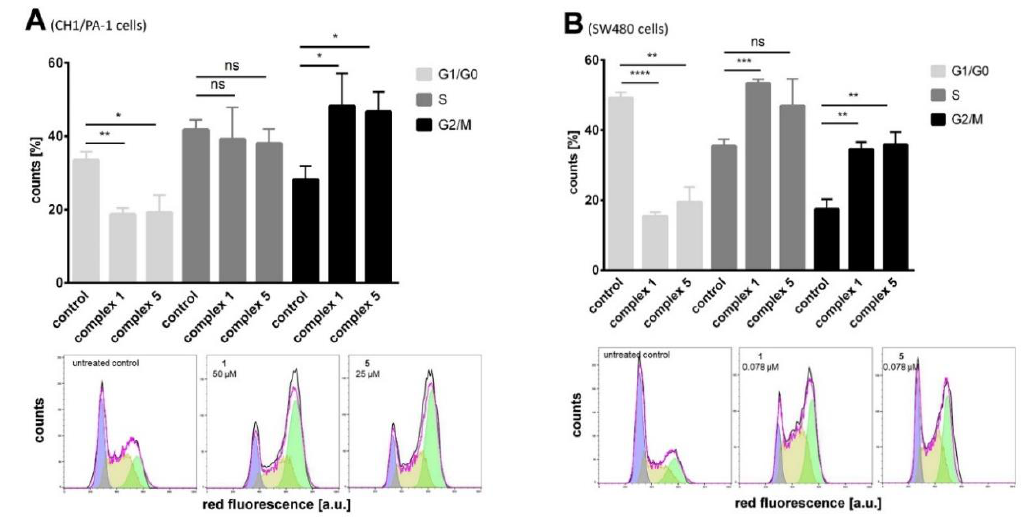
Figure 8. Impact of the most cytotoxic complexes 1 and 5 on cell cycle distribution in CH1/PA-1 ( A ) and SW480 cells ( B ) upon exposure for 24 h. Complex 1 was applied at 50 µ M concentration in CH1/PA-1 cells and 0.078 µ M in SW480 cells. Complex 5 was applied at 25 µ M in CH1/PA-1 cells and 0.078 µ M in SW480 cells. Histograms represent the effects of the IC 50 (according to MTT assays) relative to untreated control in a representative experiment. The different colors indicate the cell fractions in G1/G0 phase (purple), S phase (yellow) and G2/M phase (green), calculated by integrating the histograms of fluorescence signals by using Watson algorithm (indicated by magenta lines). In the column diagrams, the data are given as means ± SDs from at least three independent experiments. Unpaired t -test with Welch’s correction was performed for statistical evaluation (* p < 0.05; ** p < 0.01; *** p < 0.001; **** p < 0.0001; ns: not